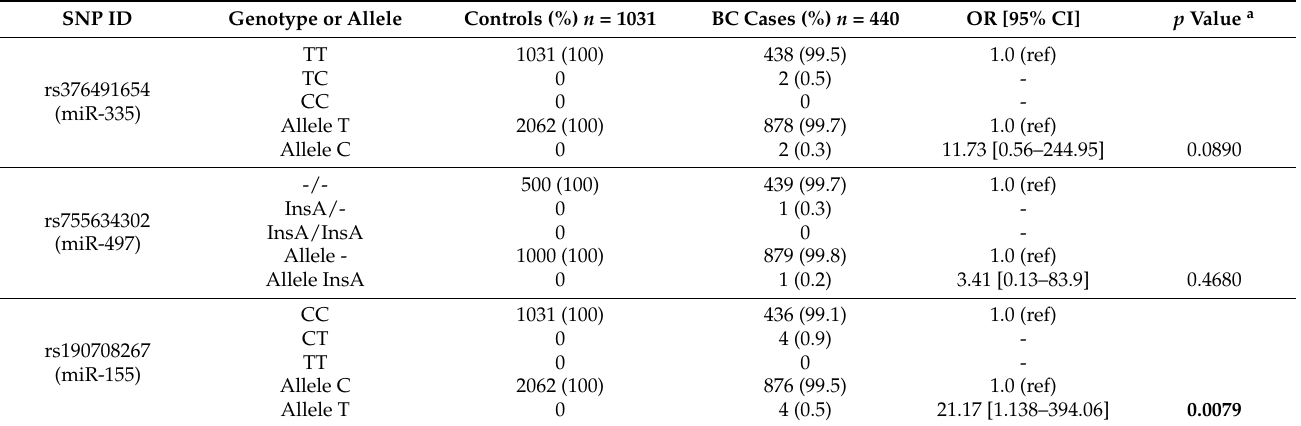
Table 2. Genotype and allele frequencies of germ variants in BRCA 1/2 negative BC cases and